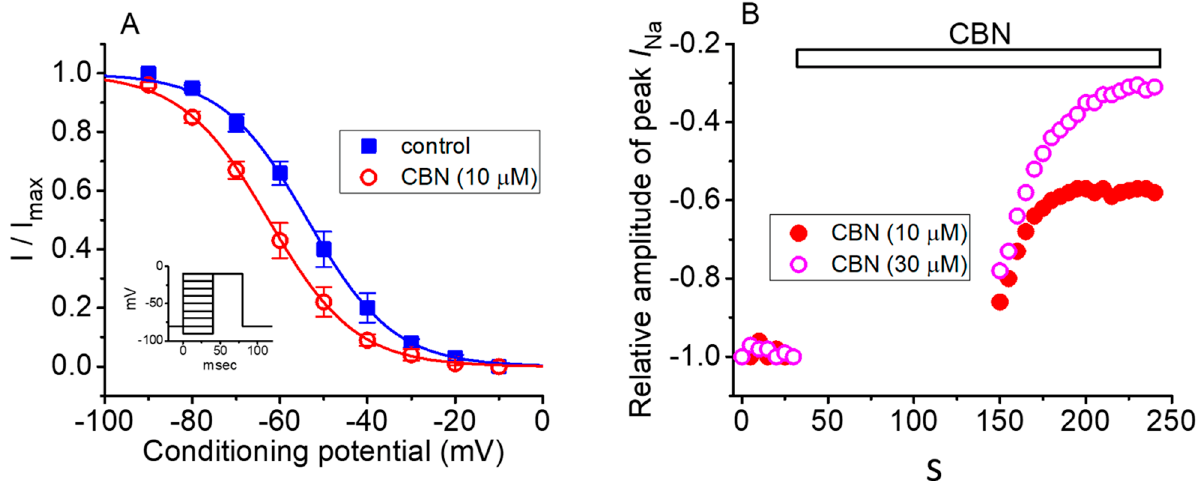
Figure 4. CBN-mediated change in the steady-state inactivation curve of peak I Na ( A ) and its tonic- and use-dependent block of peak I Na ( B ) in GH 3 cells. In these experiments ( A ), cells were immersed in Ca 2+ -free Tyrode solution, while the examined cells were held at − 80 mV, and a series of the voltage pulses ranging between − 90 and − 10 mV (as indicated in inset) were given. ■ : control (i.e., CBN was not present) and ○ : in the presence of 10 µM CBN. Each point represents the mean ± SEM ( n = 8). The sigmoid line shows the goodness-of-fit to the modified Boltzmann equation. Note that the inactivation curve of I Na was shifted to a negative direction in the presence of 10 µM CBN; however, there was lack of change in the apparent gating charge of the current. ( B ) Tonic- and use-dependent block of peak I Na by CBN. The cell was held at − 80 mV and the depolarizing pulse from − 80 to − 10 mV (40 ms in duration) was applied at 0.2 Hz. The application of CBN (10 or 30 µM) is illustrated by a horizontal bar. Changes in the relative amplitude of peak I Na during exposure to 10 or 30 µM CBN are illustrated. The peak I Na in the control was taken as -1.0. Immediately after the voltage pulses were stopped, various concentrations (10 or 30 µM) of CBN were added to the bath. The repetitive depolarizing pulses to − 10 mV at 0.2 Hz were applied again 2 min after the cessation of command pulses, but still in the continued presence of CBN (10 µM [ ● ] or 30 µM [ ○ ]). Of notice, in the presence of CBN, the peak I Na activated by the first depolarizing step following a long pause (around 2 min) had been already suppressed (i.e., tonic inhibition), and, during the repetitive stimuli, the amplitude of peak I Na was further reduced exponentially (i.e., use-dependent inhibition).